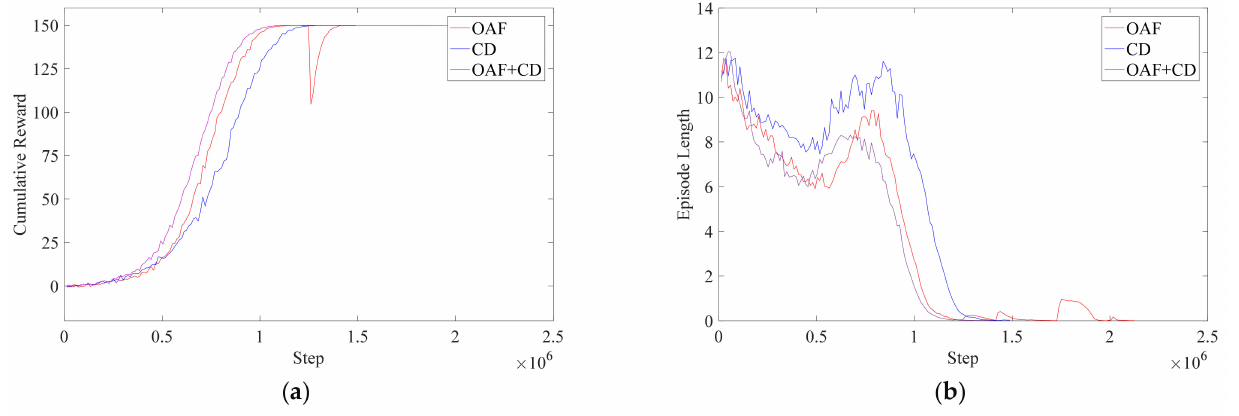
Figure 14. Training results diagram. ( a ) Cumulative Reward. ( b ) Episode